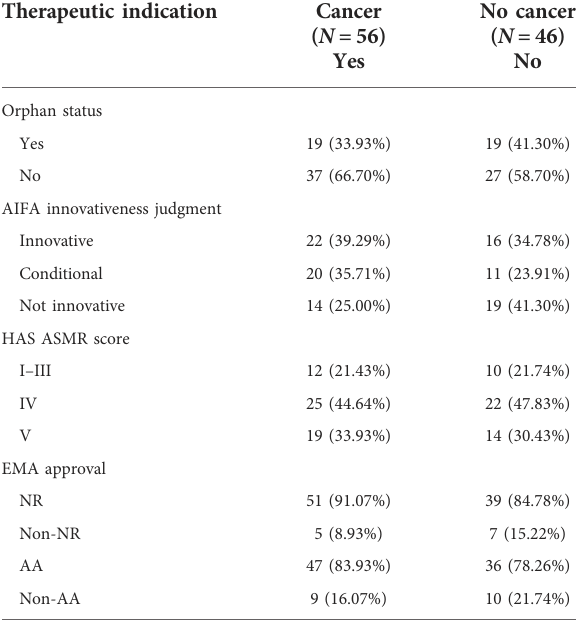
TABLE 7 Summary table on medicinal products included in the analysis focusing on the therapeutic indication. Therapeutic